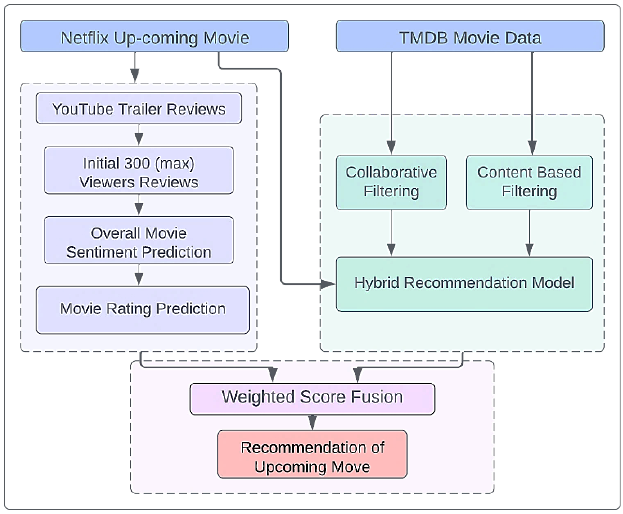
Figure 1. Framework workflow.